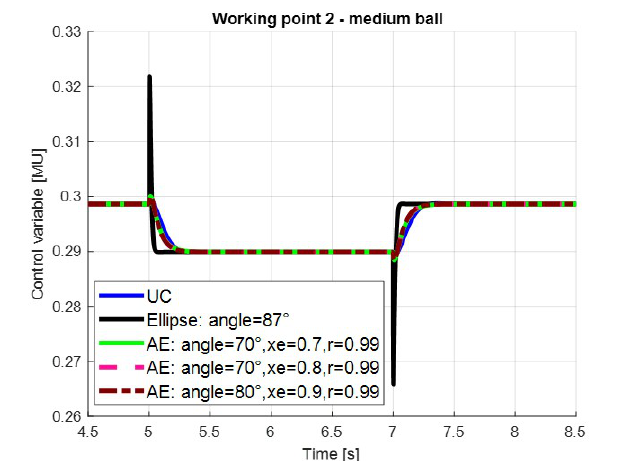
Figure 7. Control variable responses simulated on nonlinear model for the 2nd working point (medium ball) with the proposed pole-placement controllers according to legend.